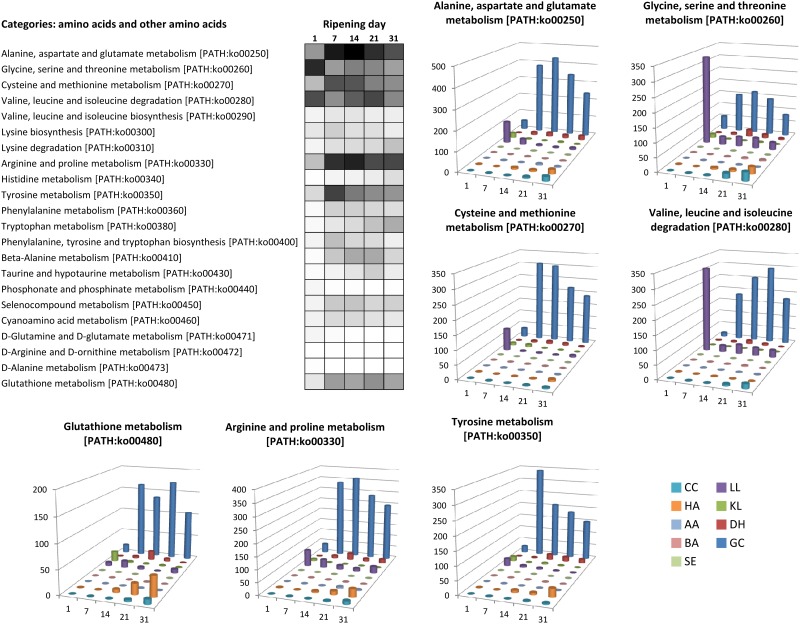
Gene expression related to amino acid metabolism.For each pathway, the heatmap represents the expression dynamics over time (cumulative number of normalized reads per pathway) using a gray scale bar from 0 read in white to 500 reads in black. For seven pathways, histogram charts detail this dynamic per microbial species. CC: Corynebacterium casei, HA: Hafnia alvei, AA: Arthrobacter arilaitensis, BA: Brevibacterium aurantiacum, SE: Staphylococcus equorum, LL: Lactococcus lactis, KL: Kluyveromyces lactis, DH: Debaryomyces hansenii, GC: Geotrichum candidum.